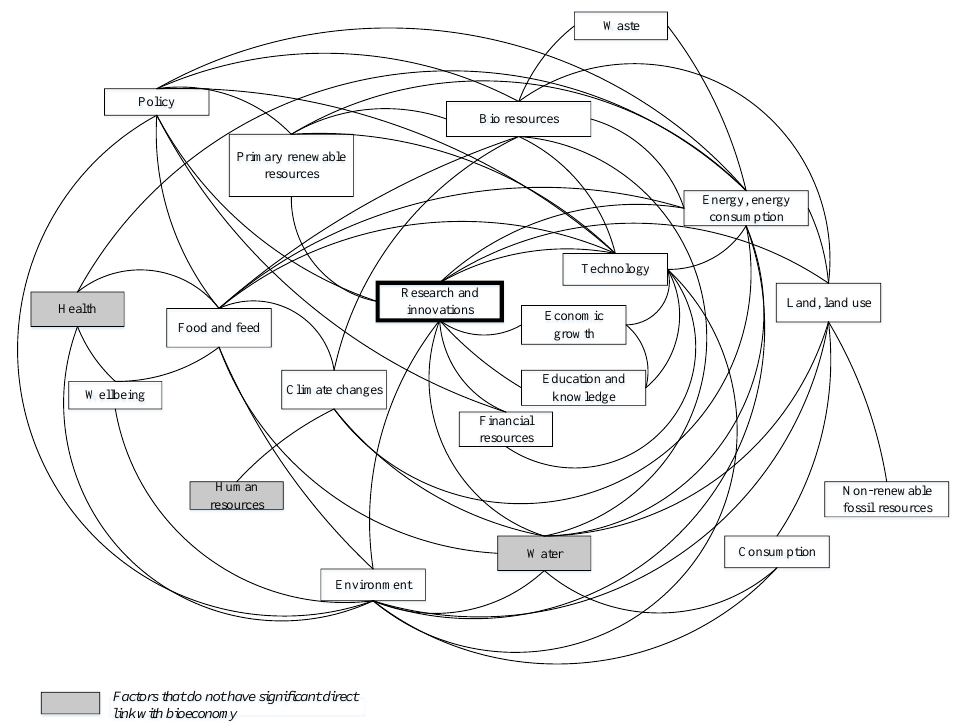
Fig. 3. Principal scheme of interaction between the factors influencing the development of